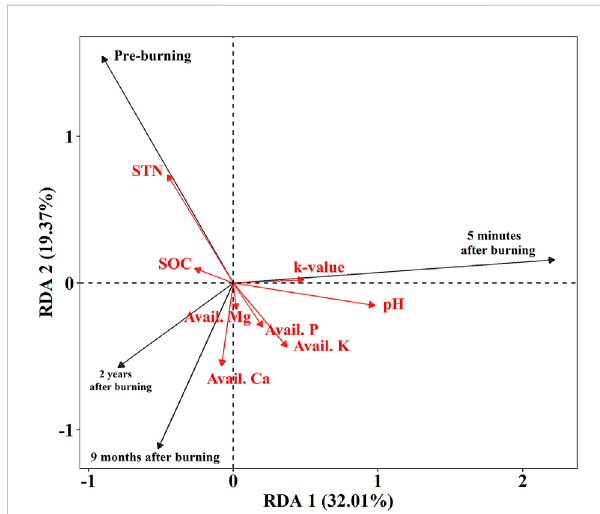
FIGURE 6 Redundancy analysis (RDA) of soil properties response variables and quantitative explanatory variables under rotational shifting cultivation before burning and at 5 min, 9 months, and 2 years after burning for three fallow fi